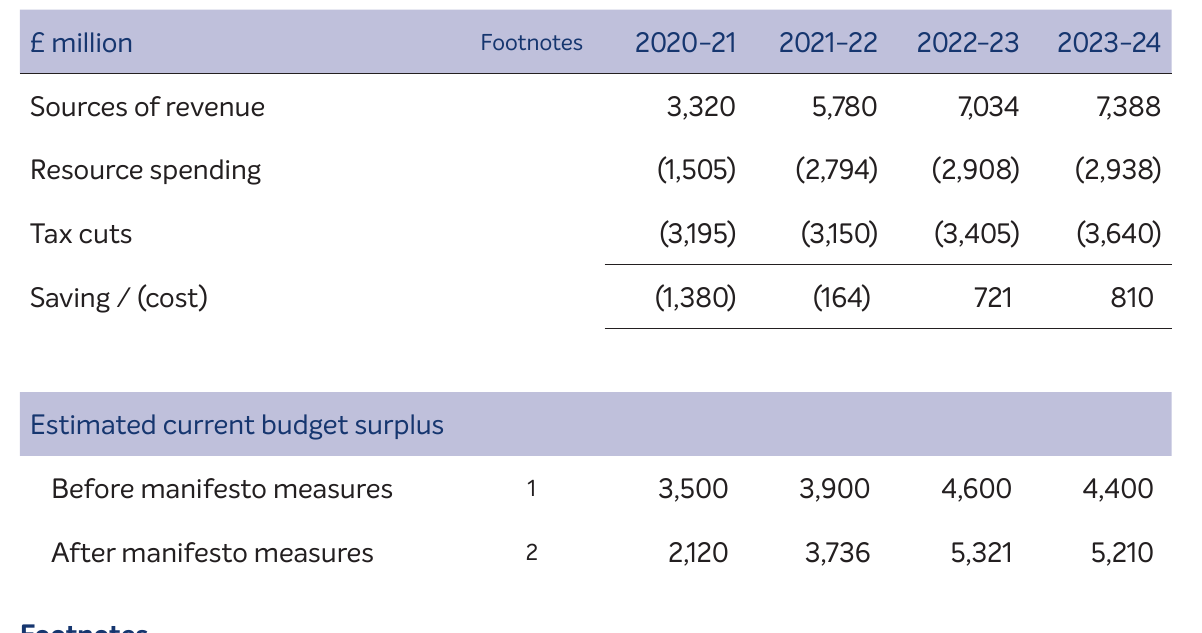
Table 5: Overall Net